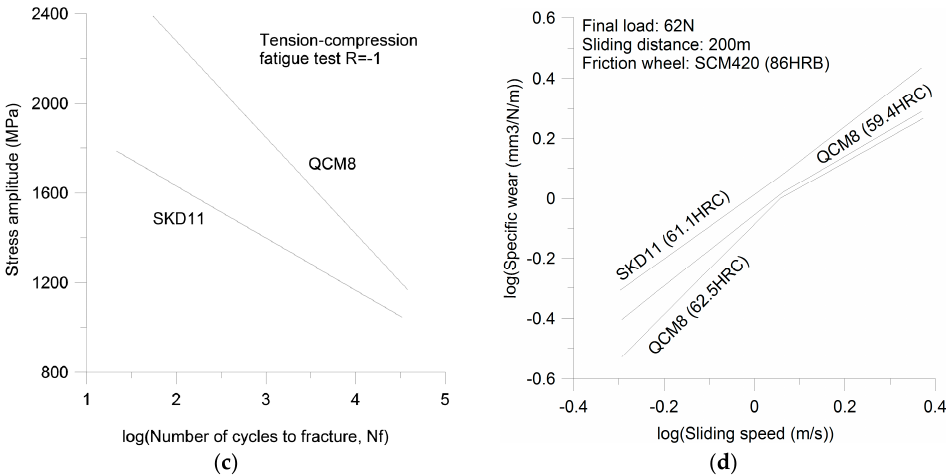
Figure 7. ( a ) Stress strain curves for M2 and D2 tool steels after ref. [2]; ( b ) Relation between hardness and tensile strength for SKD11 (D2-type) and QCM8 (low Cr version of SKD11) after ref. [18]; ( c ) Relation between stress amplitude and fatigue life for tension-compression fatigue for SKD11 (D2-type) and QCM8 (low Cr version of SKD11) after ref. [18]; ( d ) Relation between sliding speed and wear rate for SKD11 (D2-type) and QCM8 (low Cr version of SKD11) after ref. [18]. These tests are made under constant and well controlled conditions. In the real tool these conditions are not as well defined and are changing during use. There also exists a spread in properties depending on where the material fails that is both batch and supplier dependent. In an effort to capture the probabilistic nature of the tool life Engel [19] concluded that the task to predict tool life depends on 2 steps